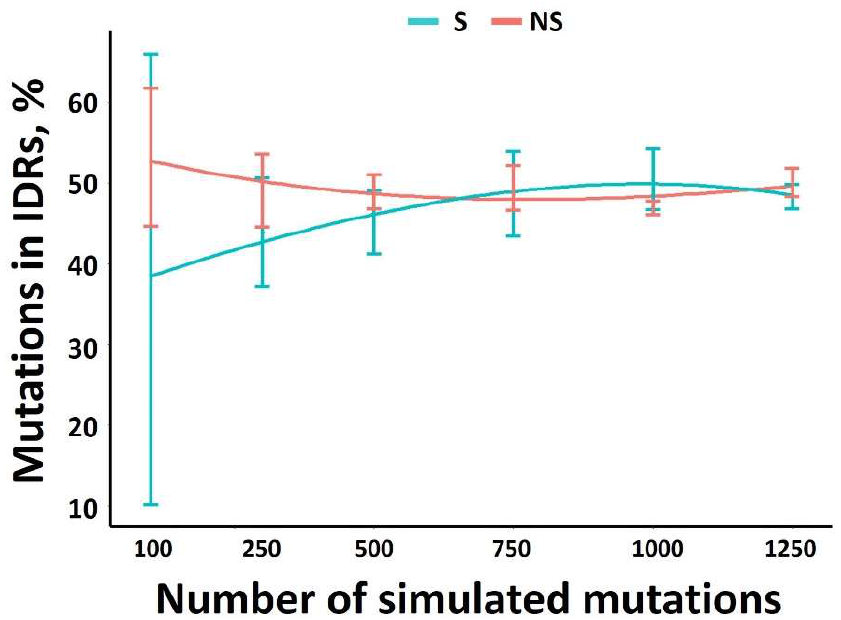
Figure 1. The % of S and NS mutations in IDRs versus the mutations number in the TEV genome. For a given number of mutations, four independent simulations were run.